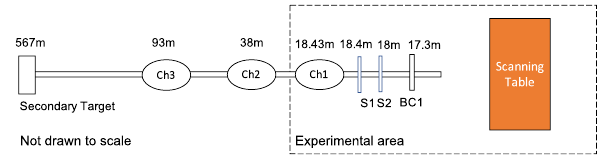
Fig. 1 Schematic layout of the H8 beam line detectors. The distances of the beam line components and of the secondary target from the scan- ning Table (on which was placed the TB calorimeter) setup are shown